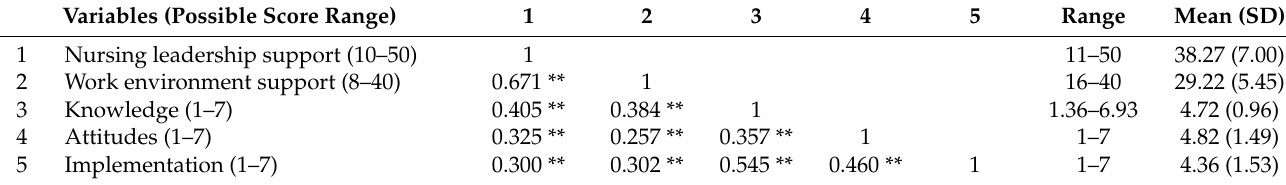
Table 2. Correlation matrix and descriptive statistics for perceived nursing leadership and